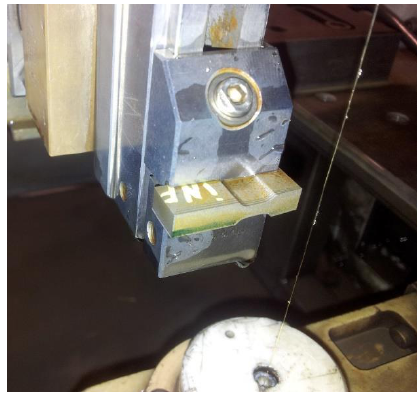
Figure 2. Slicing of one of the prisms to obtain tensile mini-samples.